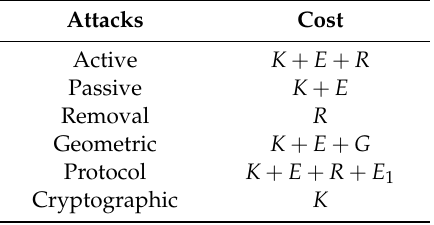
Table 4. Cost of di ff erent attacks ( K : Key, E : Embedding, R : Removal, G : Geometric distortion, E 1 : New